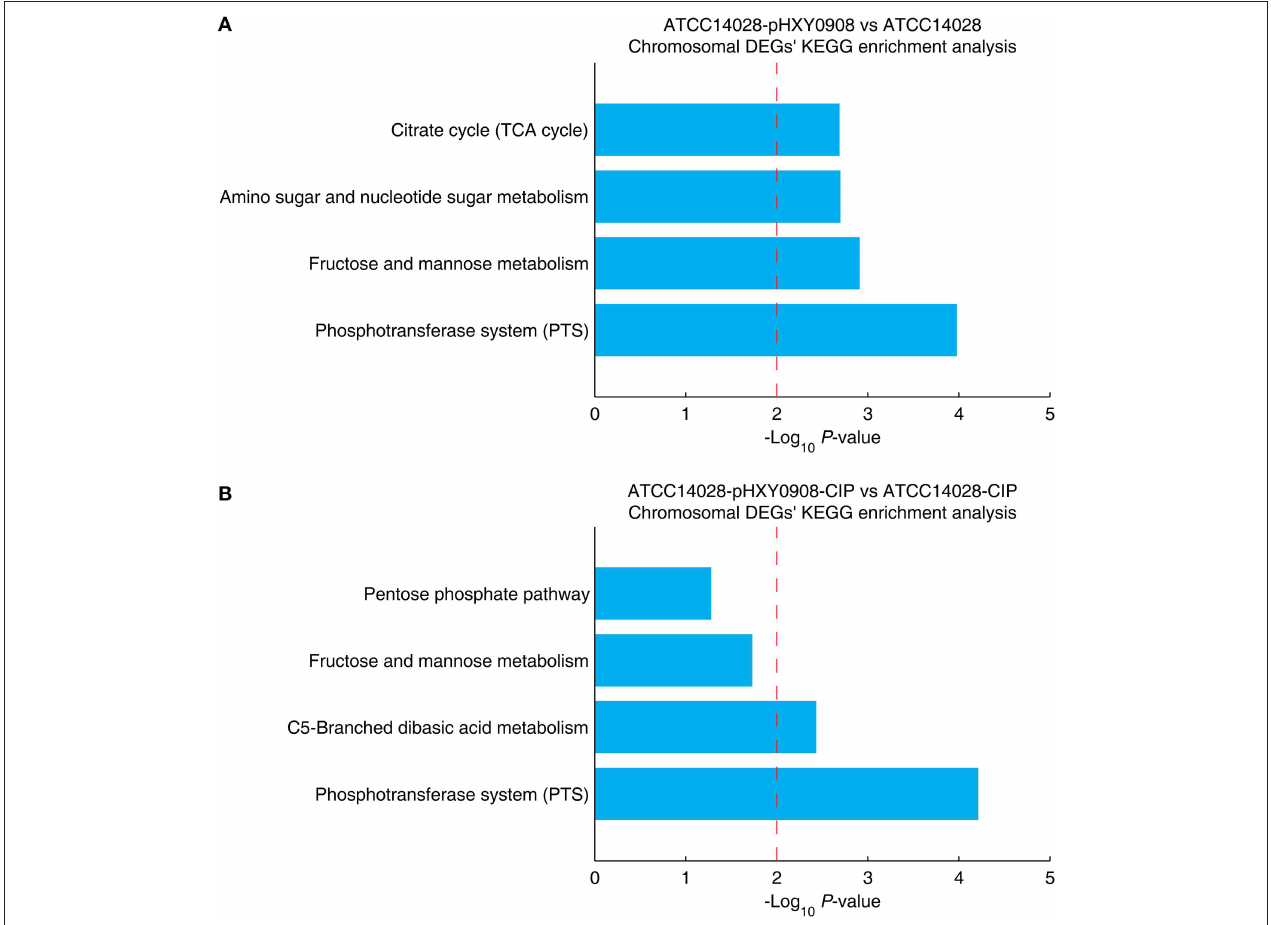
FIGURE 5 | The chromosomal DEGs KEGG pathway enrichment analysis. (A) ATCC14028-pHXY0908 vs. ATCC14028 and (B) ATCC14028-pHXY0908-CIP vs. ATCC14028-CIP (B) . The dotted red line indicates the P -value threshold of